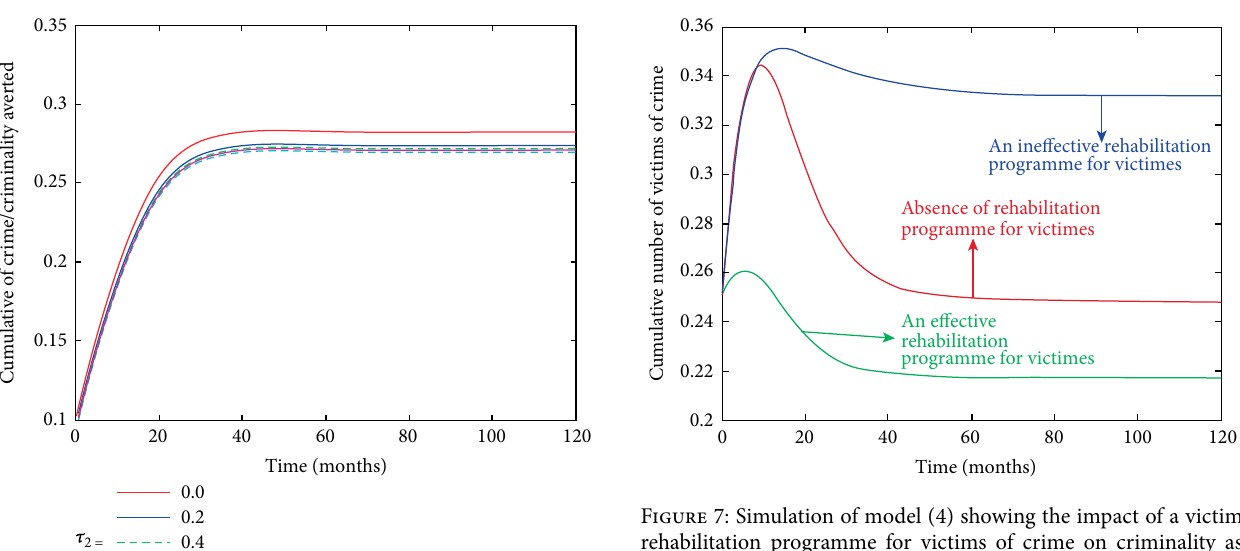
and on the 𝜏 2 𝜓 2